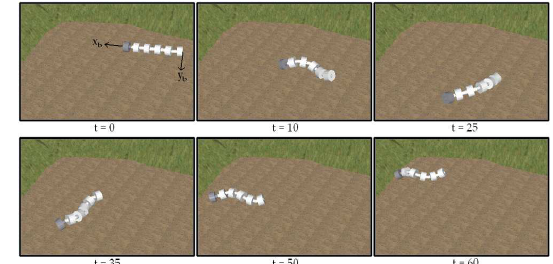
Figure 13: Locomotion by sidewinding achieved by the physical